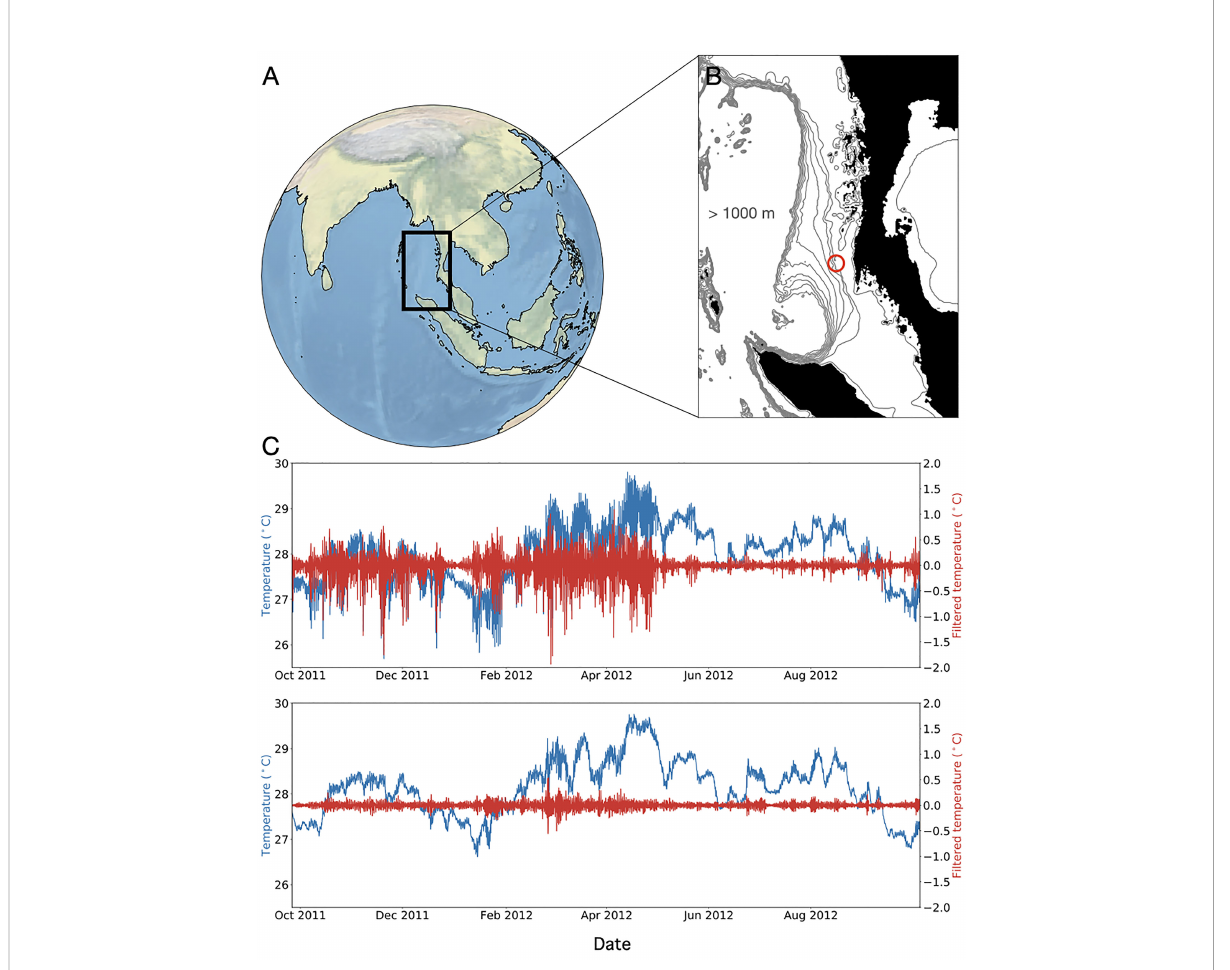
FIGURE 1 (A) Regional map and (B) bathymetric contours near Miang Island, the site of the Wall et al. (2015) study. (C) Model output of hourly temperature (blue) and fi ltered temperature (red) pro fi les from the west (top) and east (bottom) sides of the island, the differences of which are broadly consistent with the observations in Wall et al.